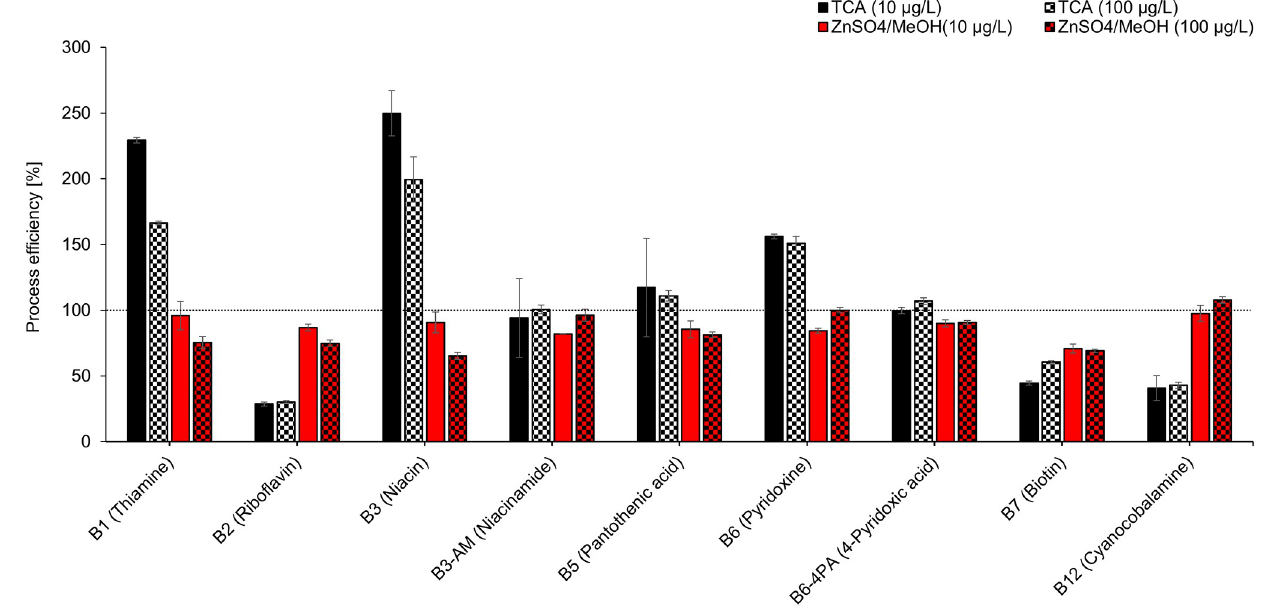
Fig 3. Effect of precipitating agent on process